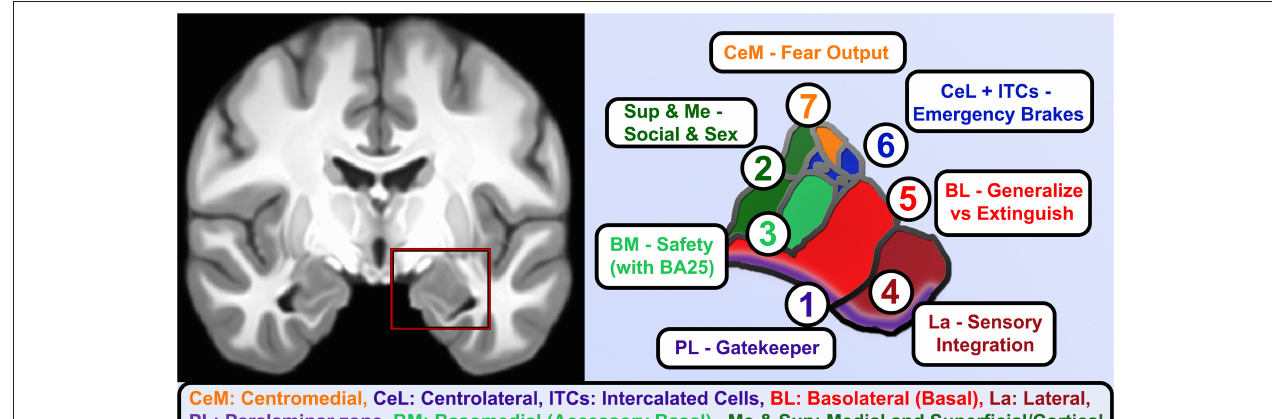
FIGURE 2 | Functional roles of human amygdala subnuclei. A coronal view of T1-weighted structural MRI (left) showing amygdalae resting on the anteriormost hippocampus and separated by the white matter of the alveus, and closeup of hand-segmented amygdala subnuclei (right). (1) While there is still debate about whether the paralaminar region is a true nucleus vs. the subventricular region of other nuclei, it is the main zone of from which newborn neurons migrate into the basal and lateral nuclei and houses dopamine-innervated GABAergic cells that gate activation of the basal and lateral nuclei. (2) The corticial nucleus and superficial nuclei are closely linked to the olfactory system and in vomeronasal animals coordinate responses to pheromones. As such, these and the medial nucleus of the amygdala contribute to latent drives such as recognition of conspecifics, maternal attachment, and sex-related differences and behaviors. (3) Basomedial nucleus is an early-developing nucleus that bears some functional similarities to the adjacent superficial nuclei, e.g., changing serotonin receptor expression in studies of early maternal separation, but also brings in information about safety cues from higher centers through direct innervation by infralimbic/BA25 projections. (4) The lateral nucleus gathers information about threatening cues and contexts from highly processed sensory information and contextual information from hippocampus. It is the largest nucleus in humans and most reliably enlarges in allostatic load, consistent with rodent studies showing dendritic expansion as fear generalizes. (5) The Basolateral or simply Basal nucleus similarly expands volume and dendrites after inescapable stress, but it is also home of key “extinction cells” that integrate information from other nuclei and prefrontal inputs and feeding forward inhibition to contextualize or extinguish threat responses and turn off dopamine from the VTA. (6) The intercalated cell islands (ITCs) and about half the cells in the lateral division of the central nucleus (CeL) receive feedforward inhibition from basal nuclei or are directly activated by the social bonding hormone oxytocin (CeL), to inhibit latent and previously learned fear responses. They receive heavy dopaminergic innervation and send effectors to centromedial (CeM) and a similar lateral-to-medial inhibition of the ascending arousal signaling of the cholinergic basal nucleus of the stria terminalis. About half the neurons are so-called “fear on” neurons that signal latent and previously-learned fears with some threat signals from innervation by the paraventricular thalamus. (7) CeM sends long-range projections that tonically inhibit hypothalamic and brainstem autonomic centers until fear and safety signals integrated by CeL shifts toward threat and inhibits these